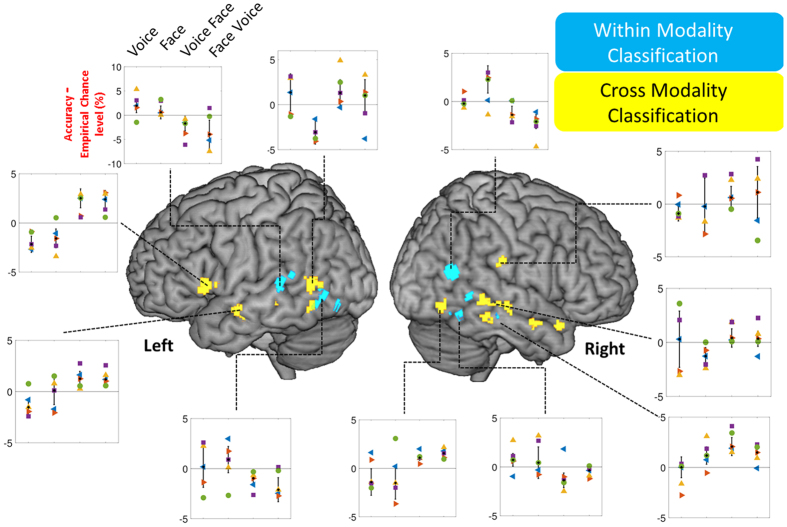
Identity cross-classification in multiple cortical areas.Voxels overlaid in color on surface rendering of the left and right hemispheres are the centers of spherical ROIs resulting in significantly (q < 0.01 FDR corrected) above-chance classification of the stimulation conditions in at least 4 of the 5 subjects. Blue voxels: above-chance within-modality classification (train on voice and test on voice; train on face and test on face); Yellow voxels: above-chance cross-modal classification (train on voice and test on face; train on face and test on voice). Panels show for selected clusters the individual values (coloured shapes: Subjects 1–5) of the cluster-average difference between classification accuracy and the empirical chance level (determined via permutations for each voxel) for each of the four classification schemes. Bars indicate standard deviation across the group mean. Voice: train and test on voice; Face: Train and test on face; Voice-Face: train on voice and test on face; Face-Voice: train on face and test on voice.